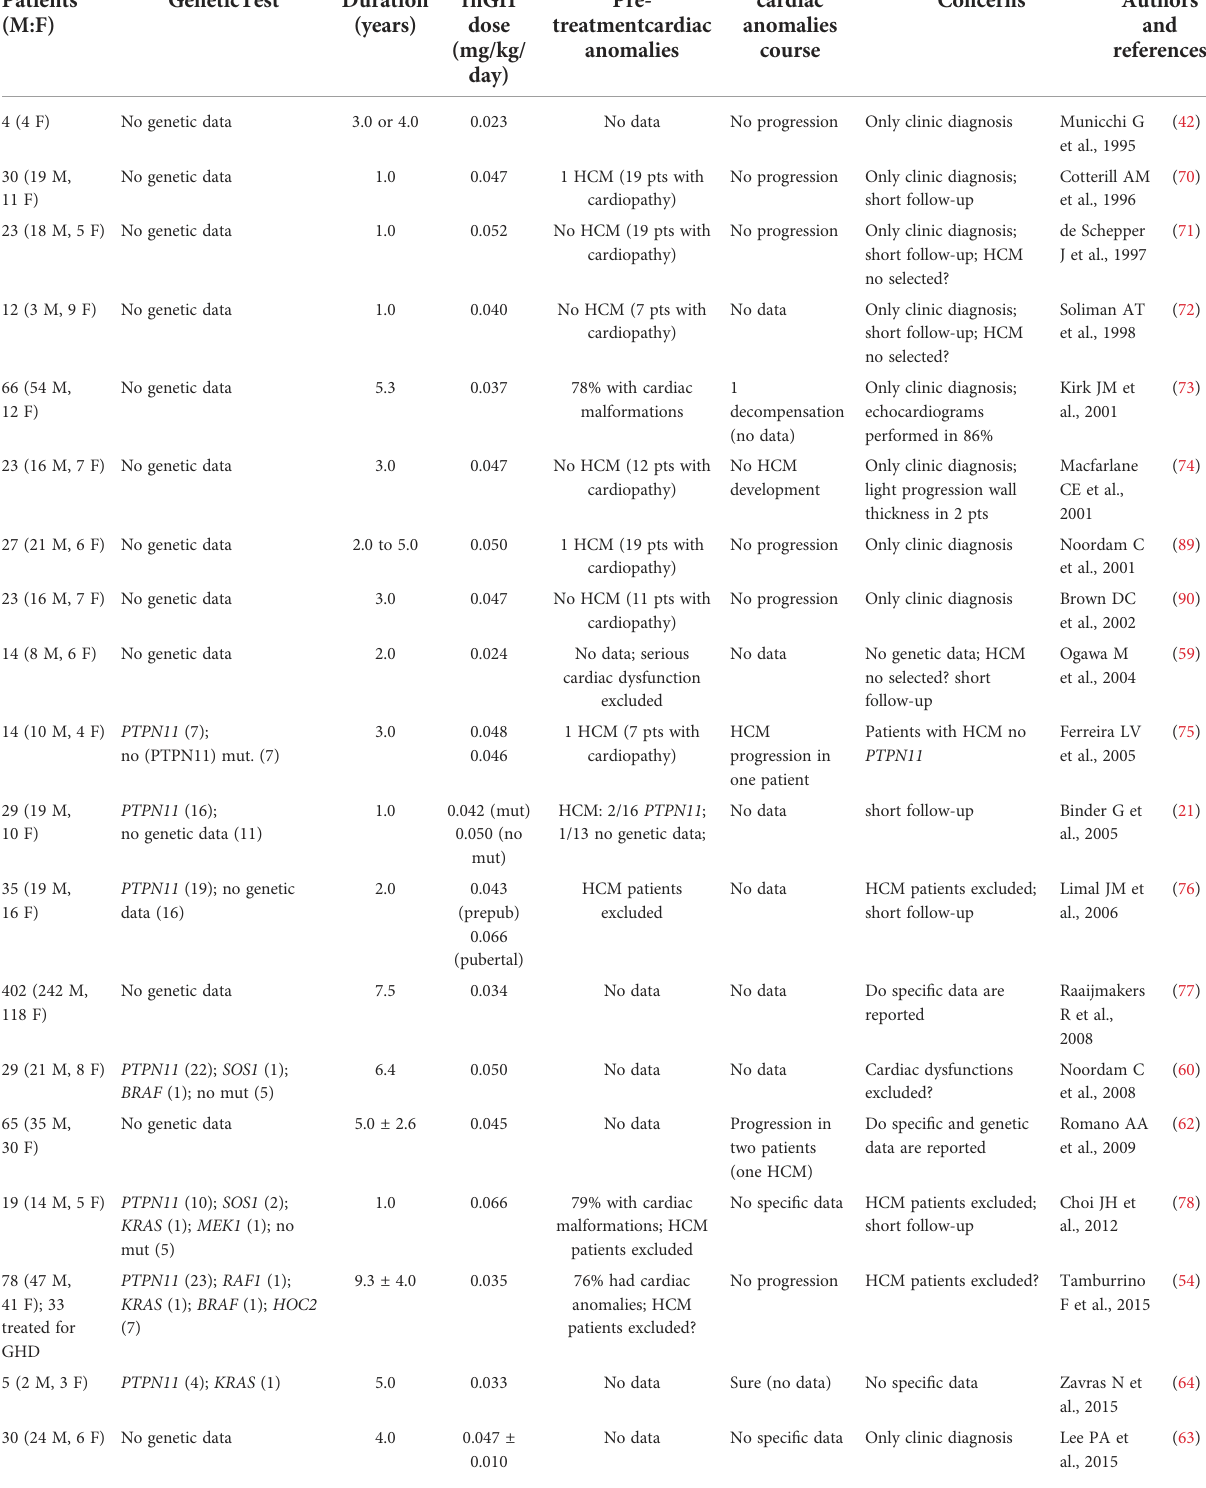
TABLE 2 Studies evaluating the course of cardiac anomalies during rhGH treatment in rasopathies. Patients